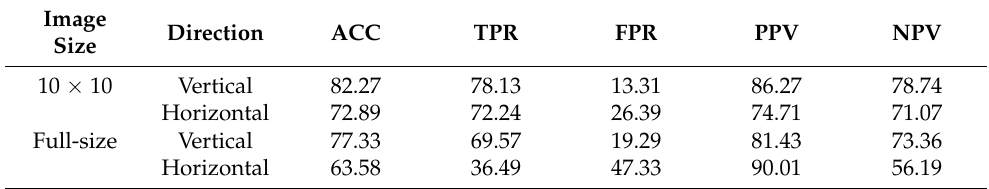
Figure 9. Comparison of the results of the vertical and horizontal steerable filters, Gaussian filter, and binary operation. Table 2. Performance evaluation metrics for vertical and horizontal steerable filtered